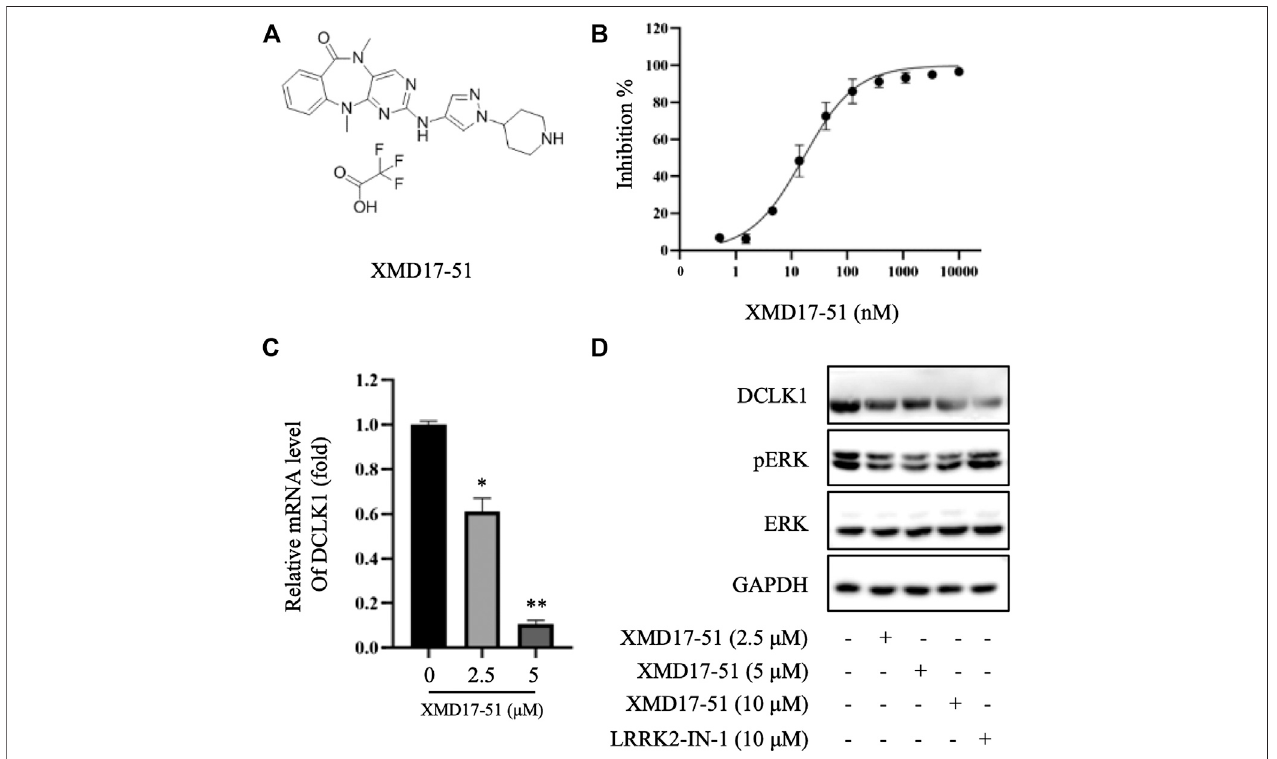
FIGURE 1 | XMD-17-51 inhibits DCLK1 kinase activity. (A) Molecular structure of XMD-17-51. (B) XMD-17-51 inhibited DCLK1 kinase activity in an in vitro kinase assayperformedusingpuri fi edactiveDCLK1kinase. (C) XMD-17-51decreasedDCLK1mRNAexpressionlevelsinA549cells,asshownbyRT-qPCR(normalizationto GAPDH levels). Data are presented as fold change relative to the DCLK1 levels in vehicle control cells. (D) DCLK1 and its downstream target protein level in A549 cells were decreased signi fi cantly following treatment with XMD-17-51, GAPDH was used as a loading control. The data shown are (A , D) representative of or (B , C) are presented as the mean ± SD of at least three independent experiments. DCLK1, doublecortin-like kinase 1.